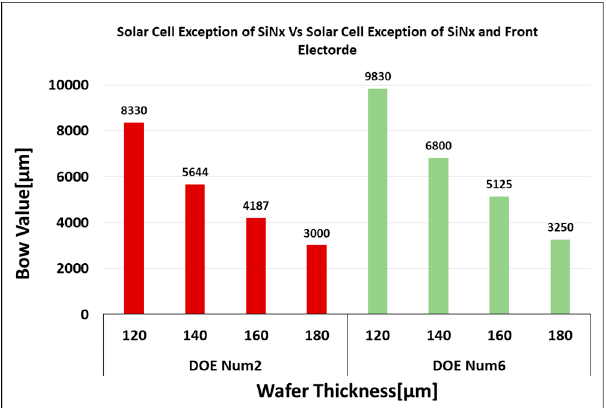
Figure 8. Bowing phenomenon due to thickness of wafer and presence or absence of front-side electrode deposition on a c-Si wafer.